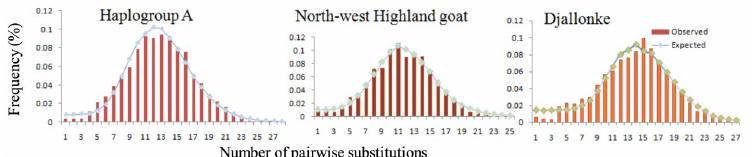
Fig 4. Demographic dynamics revealed by mismatch distribution analysis for haplogroup A goats and for indigenous Djallonke and North-west Highland goat populations in Cameroon.